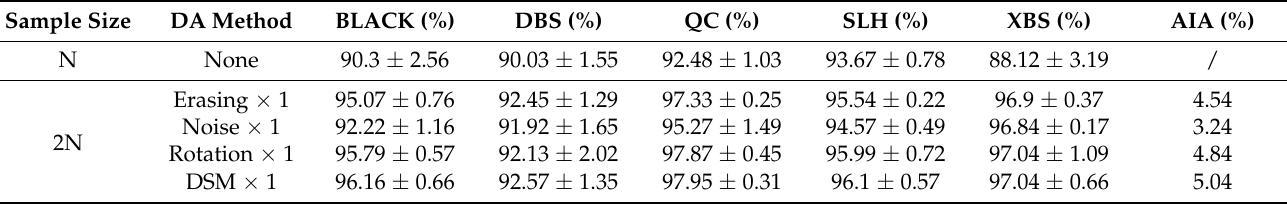
Table 7. Results of MobileViT-xs training using all gradient